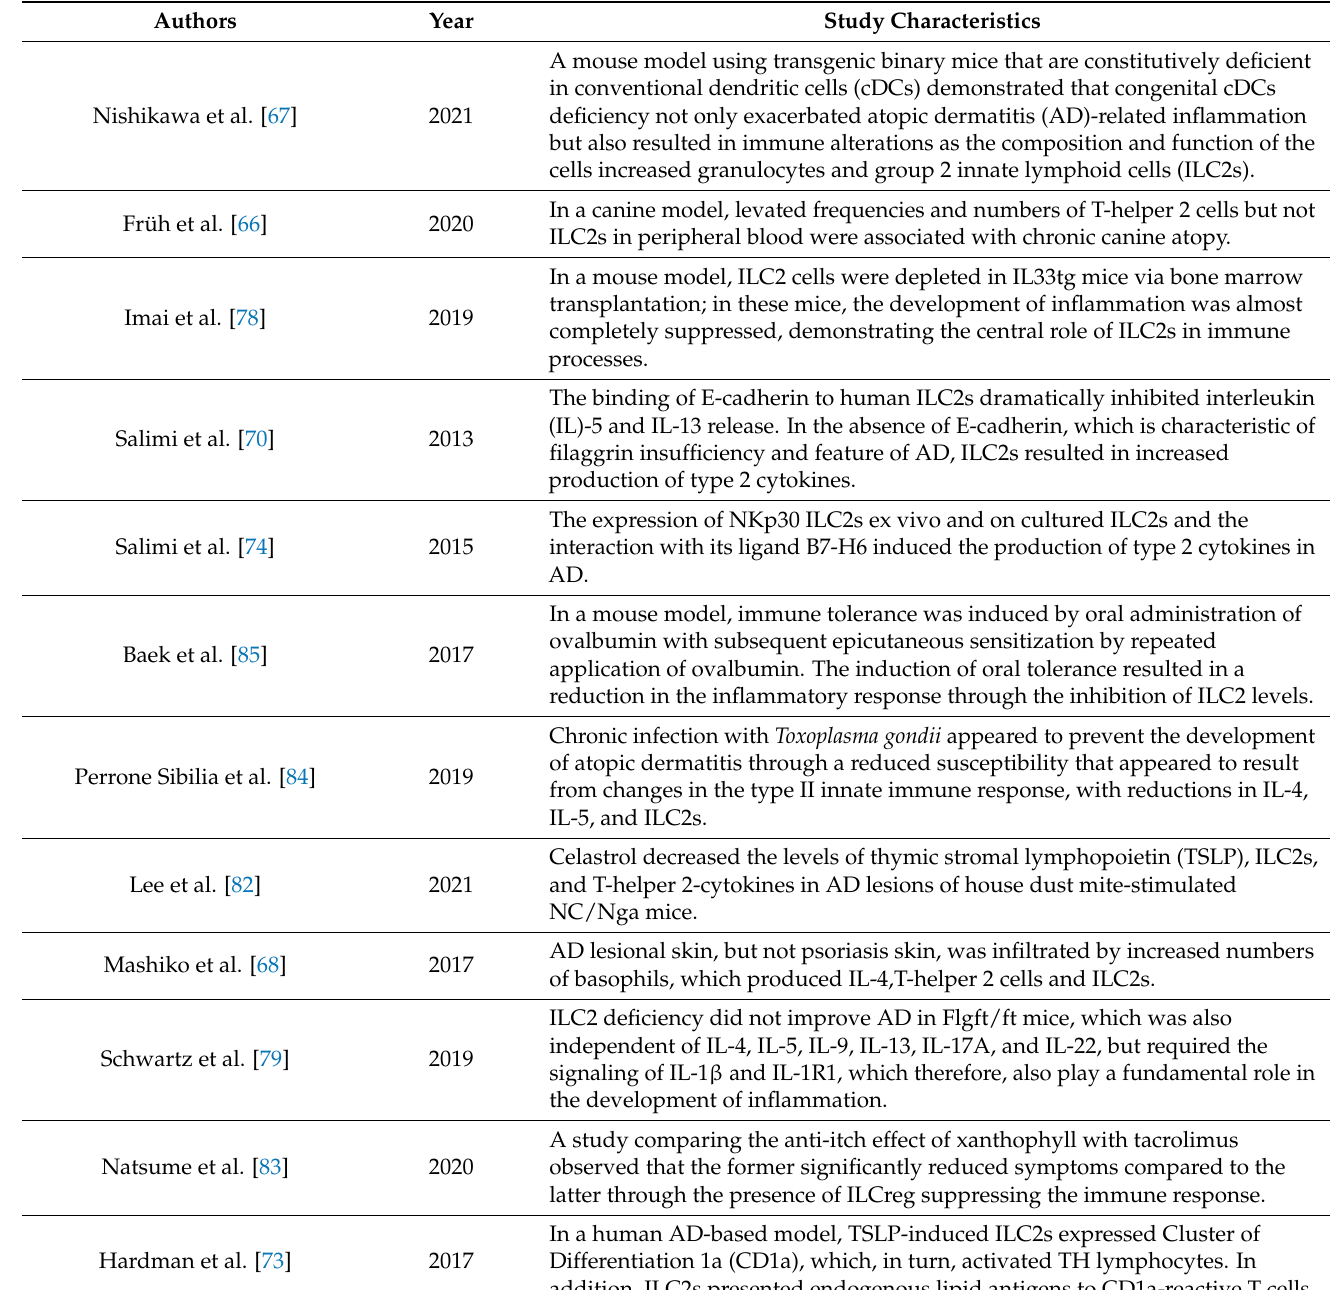
Table 3. The main finding about the role of ILC2s in atopic